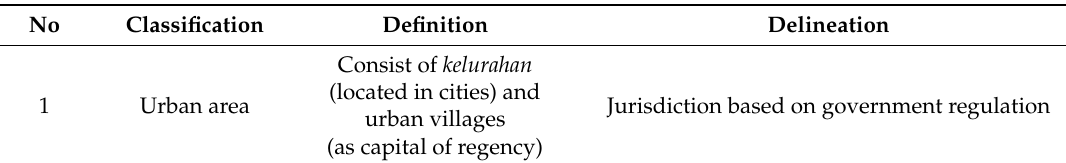
Table 3. Rural and Urban